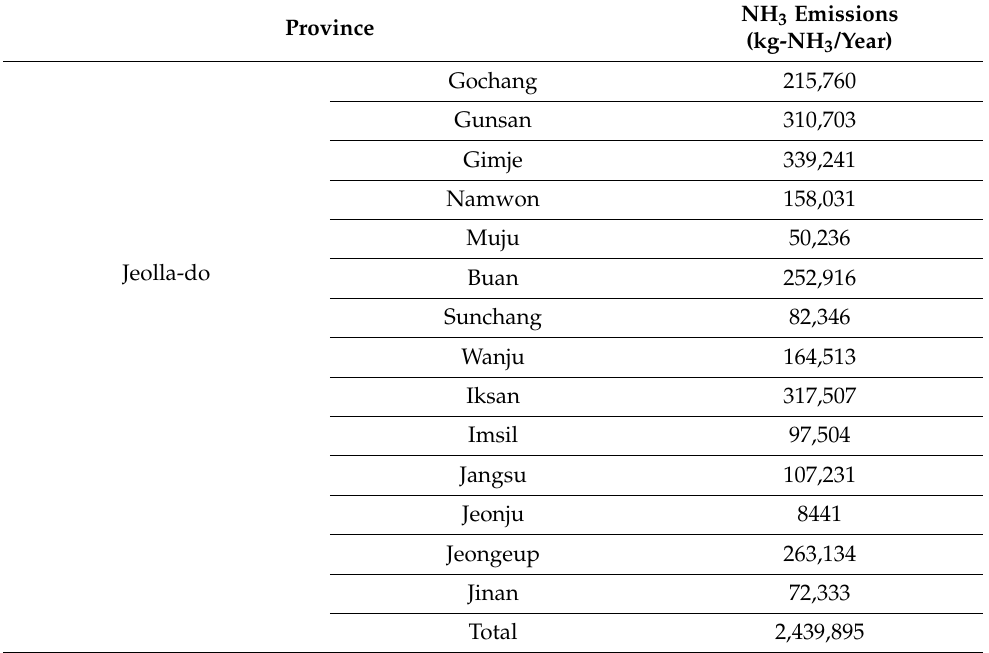
Table 8. NH 3 emissions in Jeolla-do(2017) with Method